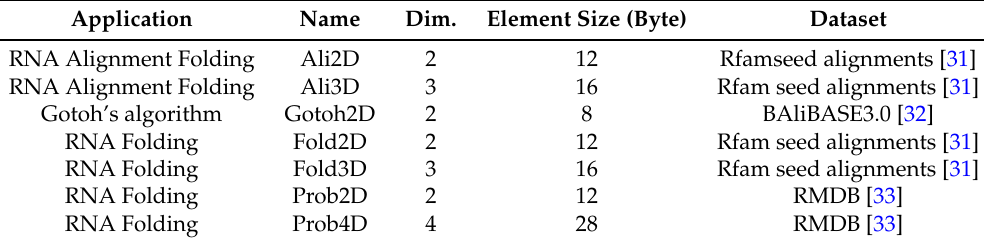
Table 2. Summary of test cases with essential properties and used databases as input. Element sizes are estimates only for the forward phase of the computation and are only valid for the used test system. They may vary on other systems or differ in reality due to memory padding. For the backward phase, string representations of candidates are added, so no general estimate can be made on their